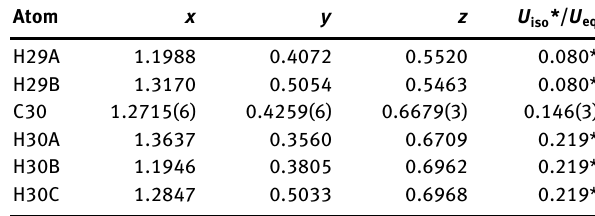
Table 2: Fractional atomic coordinates and isotropic or equivalent isotropic displacement parameters (Å 2